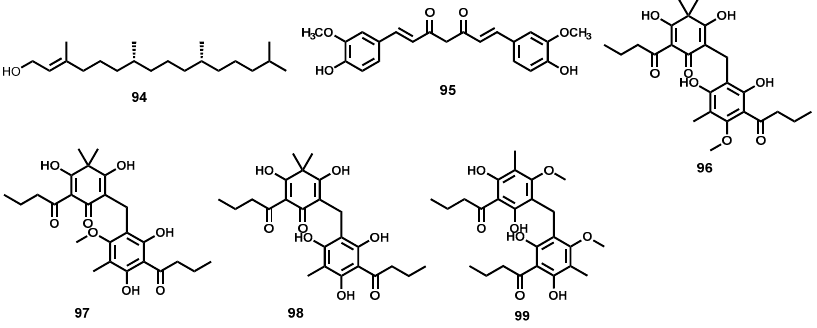
Figure 15. Antischistosomal phloroglucinols, curcumin, and phytol.